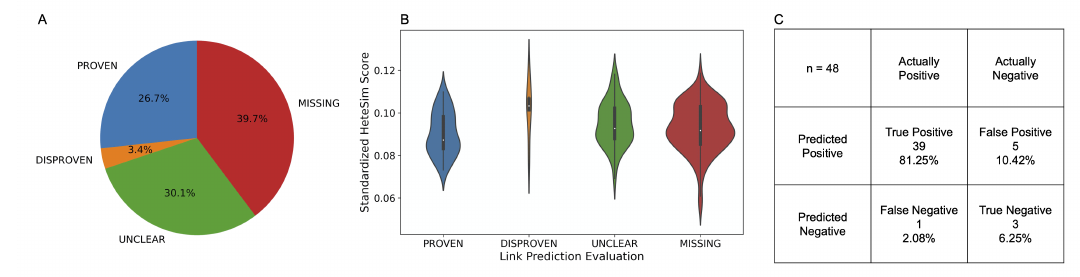
Figure 9. ( A ) Pie chart illustrating the composition of the COVID-19 case study dataset by link prediction evaluation. ( B ) Violin plot showing the distribution of standardized HeteSim scores between each link prediction evaluation. Lower HeteSim means a closer relationship between the source node and tail node. ( C ) Confusion matrix for the link predic- tion in the COVID case study. “MISSING” and “UNCLEAR” nodes were left out as the true relationship is unknown. Sensitivity = 0.975, specificity = 0.375.